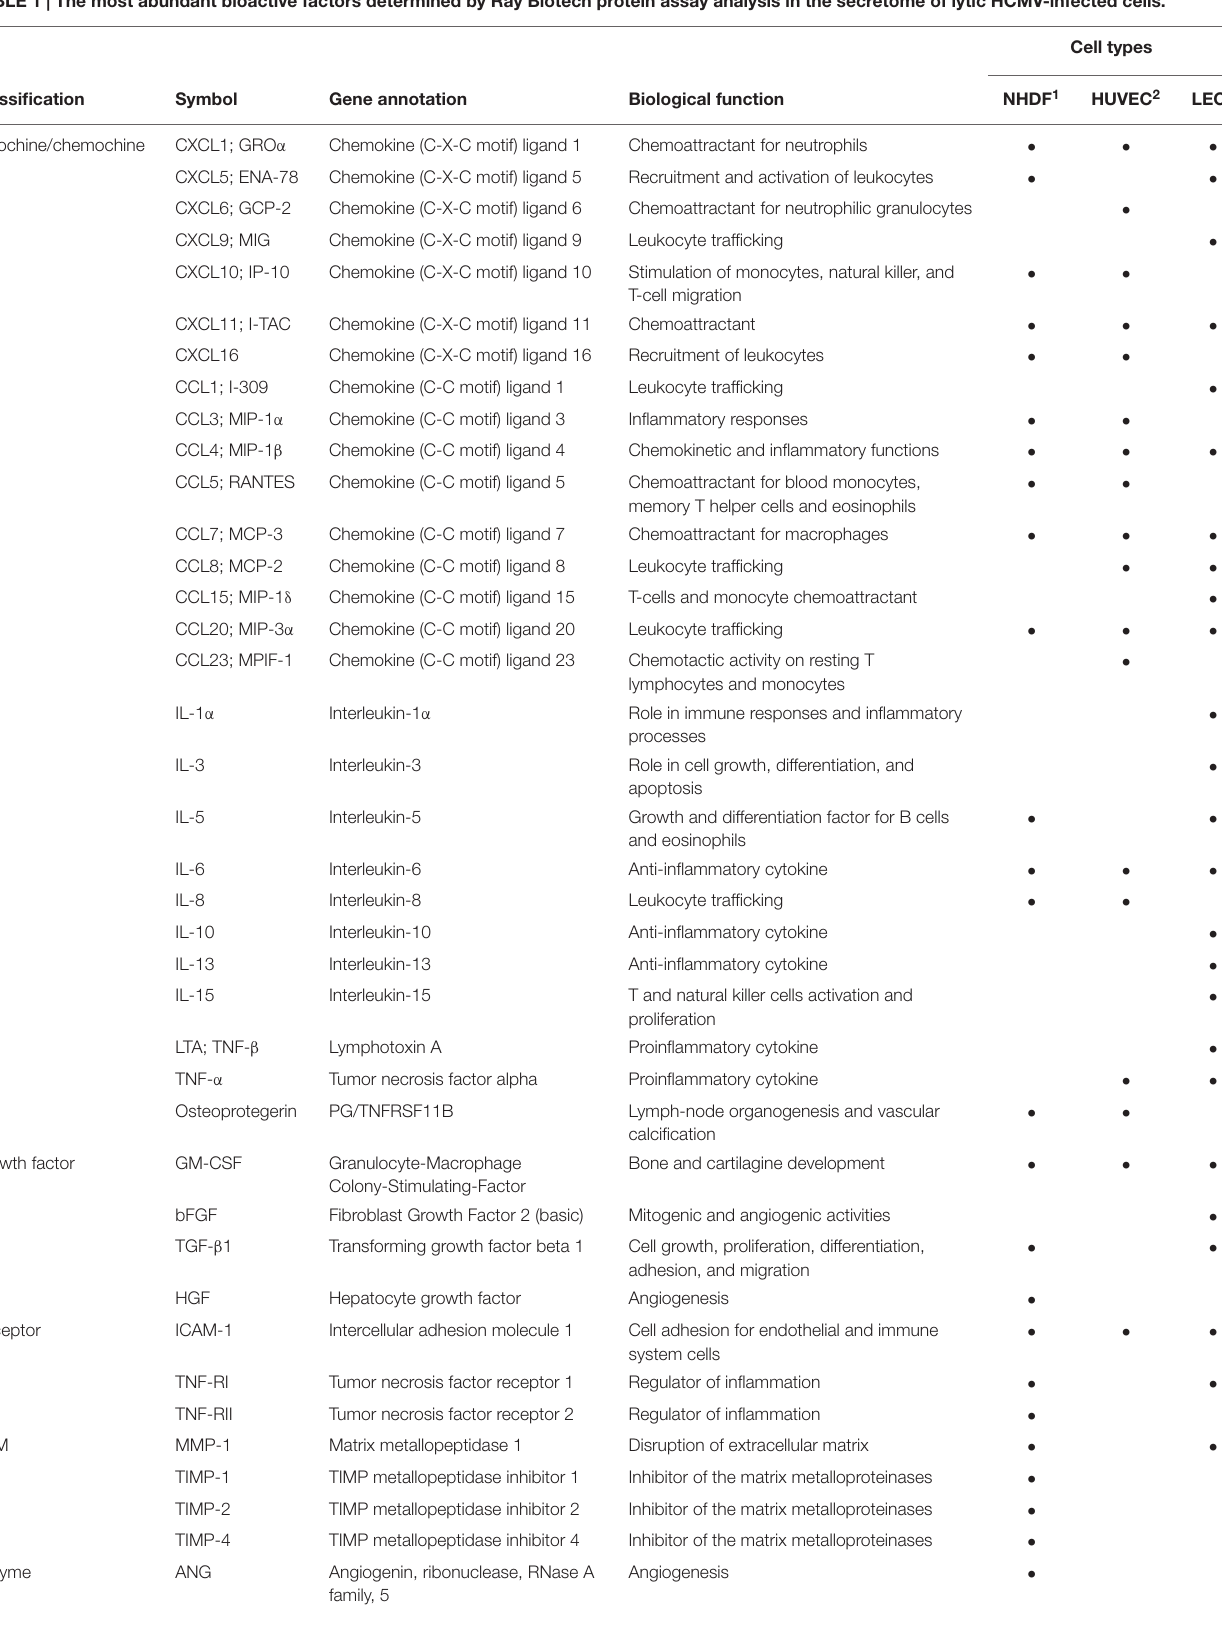
TABLE 1 | The most abundant bioactive factors determined by Ray Biotech protein assay analysis in the secretome of lytic HCMV-infected